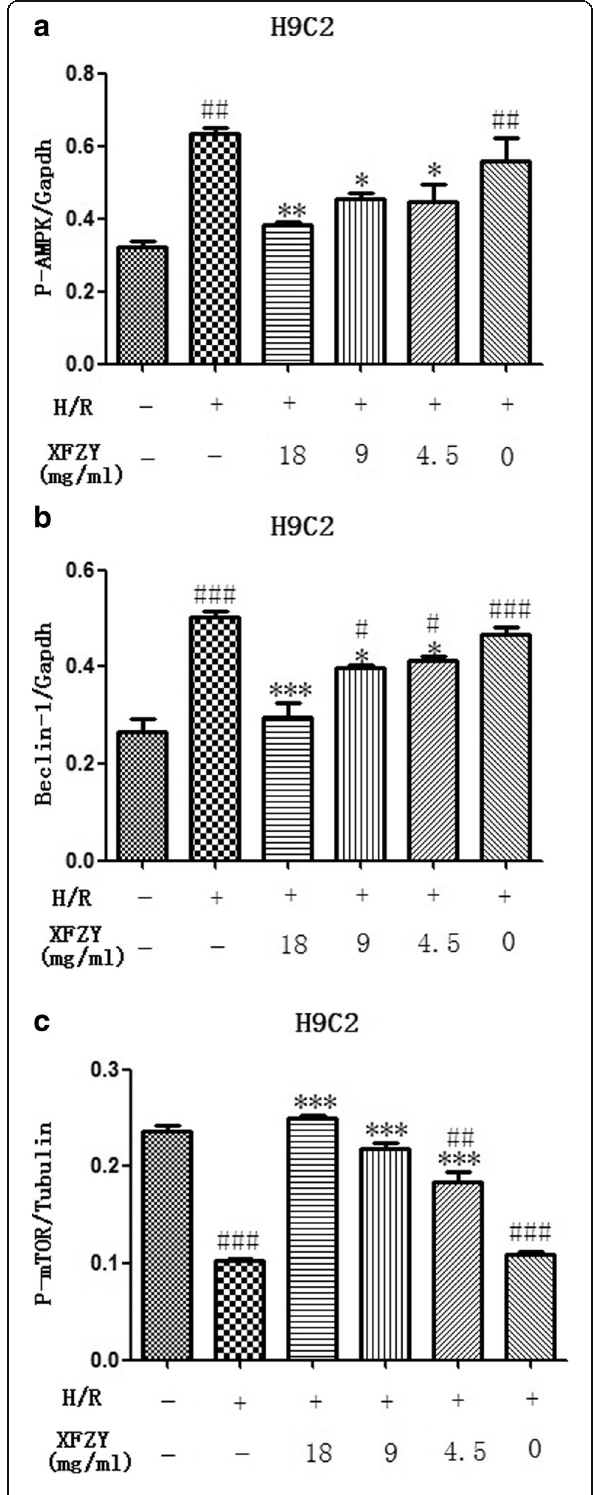
Fig. 7 XFZY inhibited autophagy through AMPK-mTOR pathway in H9C2 cells subjected to H/R. H9C2 cells were treated with XFZY under H10/R2. Expressions of AMPK a , beclin-1 b and mTOR c were examined by western blot. The data were expressed as the means ± SD of three independent experiments. ***p < 0.01, **p < 0.01, *p < 0.05 vs H/R group; ### p < 0.001, ## p < 0.01 vs Vehicle